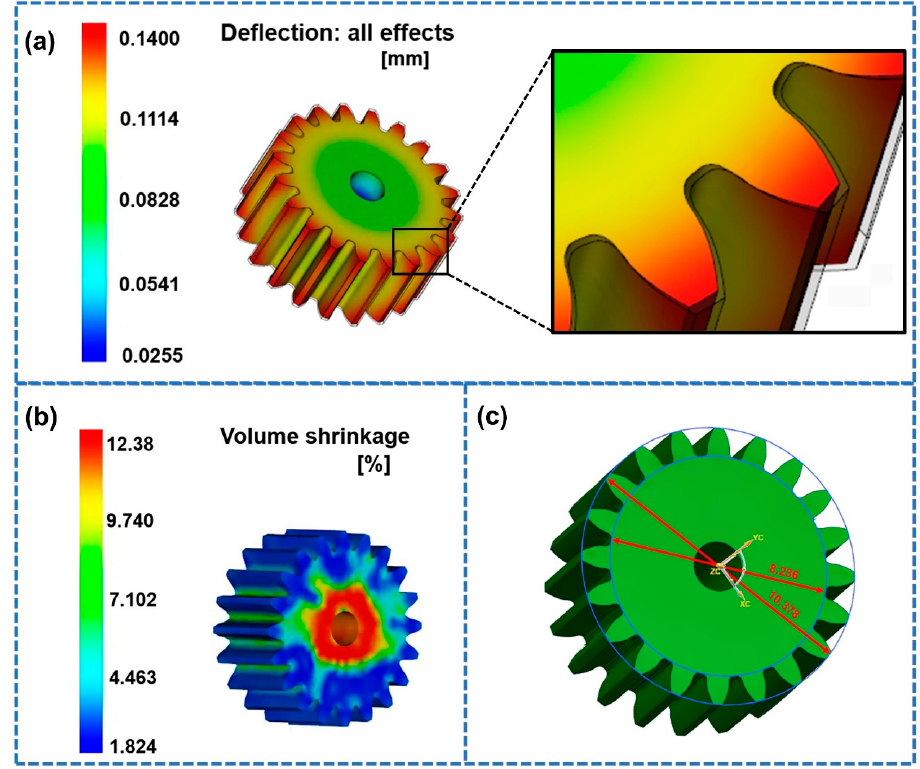
Figure 12. Simulation results under the optimal parameters. ( a ) Shrinkage cloud diagram. ( b ) Volume shrinkage. ( c ) Addendum diameter and root circle diameter.